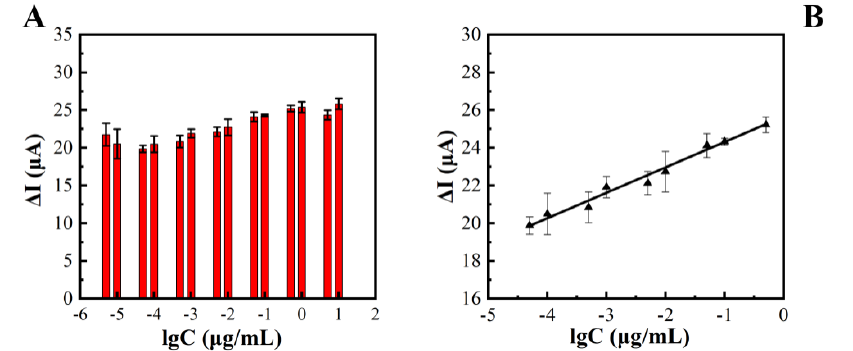
Figure 5. Relationship between TeA concentrations and differences in the peak value of the DPV current ( A ). Linear plot between Logarithm of TeA concentration versus current response ( μ A) ( B ). Table 2. Comparison of the proposed aptasensor with those reported in the literature.